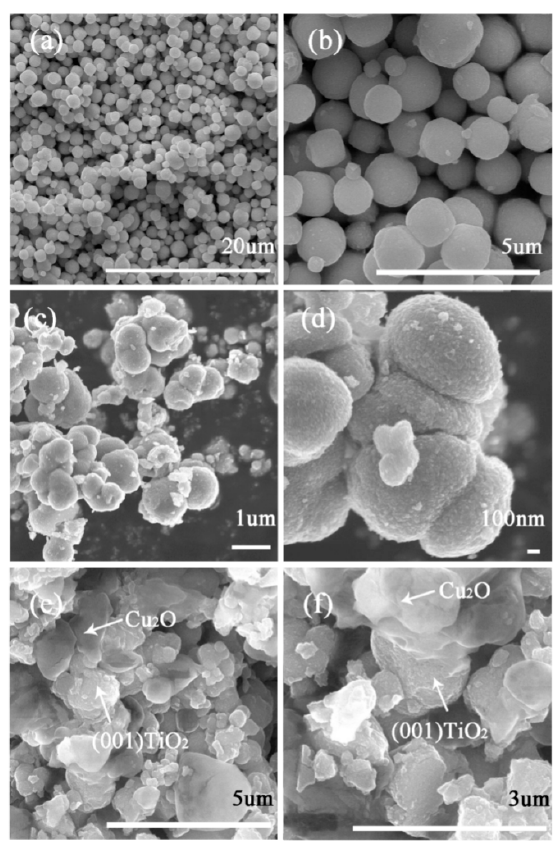
Figure 5. SEM images of the catalysts. ( a , b ) Cu 2 O; ( c , d ) (001)TiO 2 ; ( e , f ) Cu 2 O/(001)TiO 2.